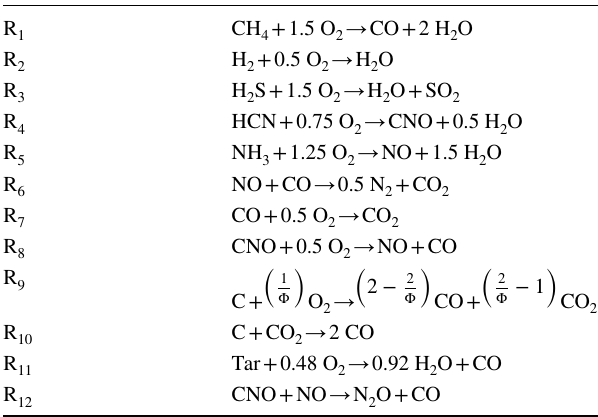
Table 2 Set of reactions involved in fuel combustion process in FBR